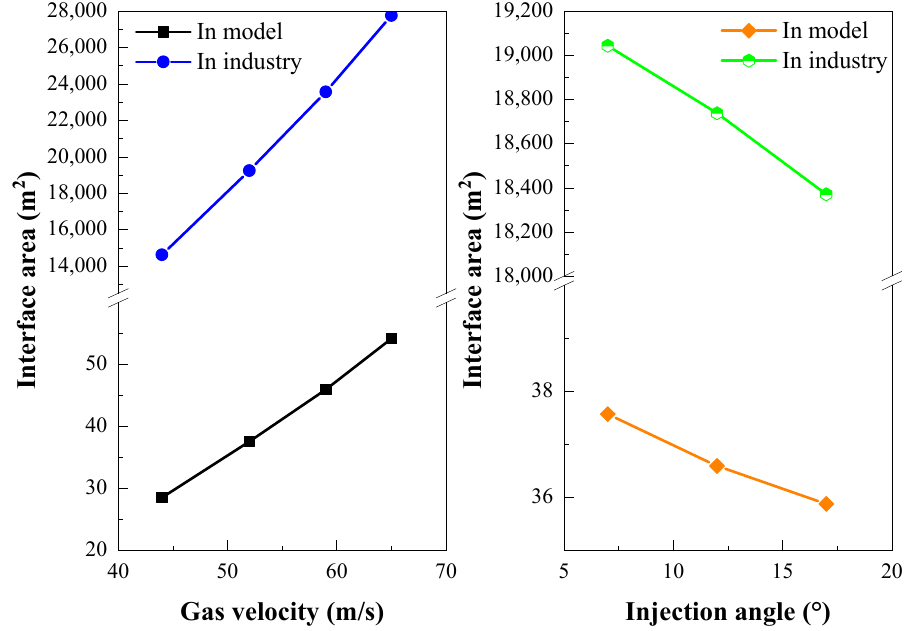
Figure 8. The interfacial area in the emulsion region against gas velocity and injection angle.